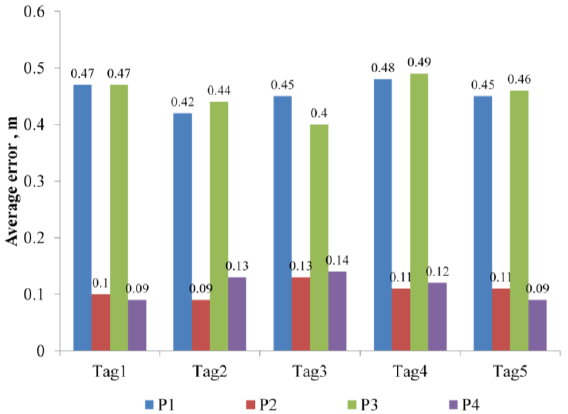
Figure 10. Average error evaluation of each tags.